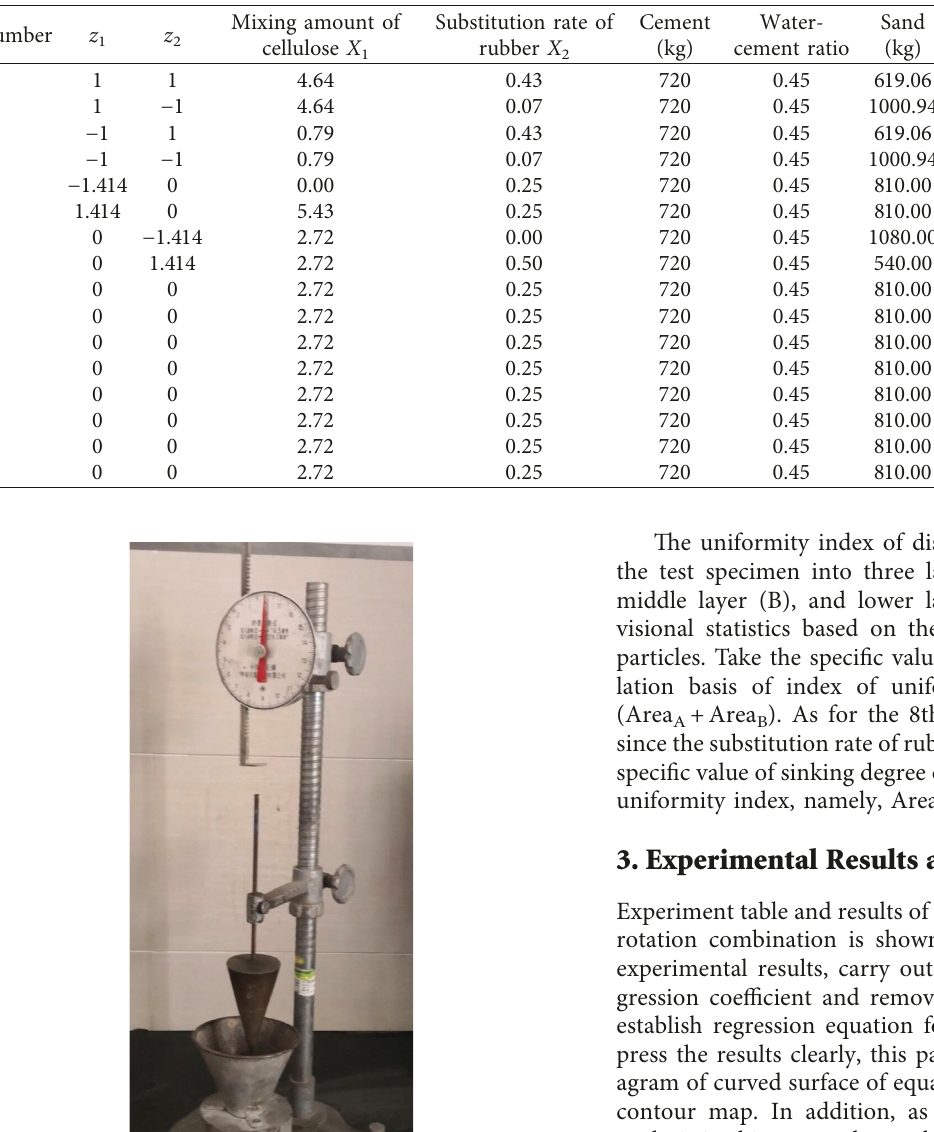
Table 6: Design of experimental scheme and mix proportion.